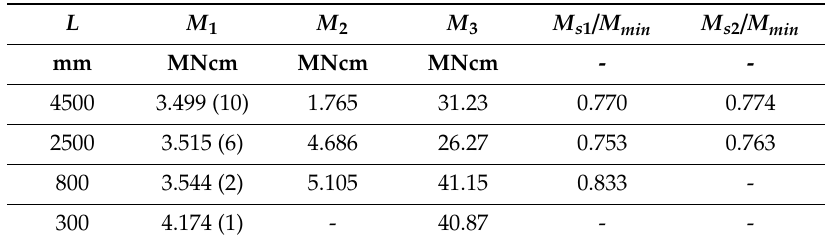
Table 4. The buckling moments M r with the corresponding number of half-waves m of buckling along the longitudinal direction of the LC-3 and the dimensionless ratio of load carrying capacities M s / M min for di ff erent lengths L .